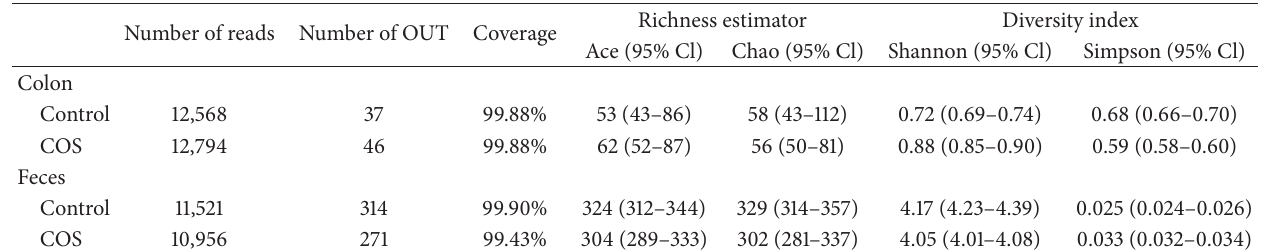
Table 1: Comparative results of 16S rRNA gene libraries’ phylotype coverage and diversity at 97% similarity based on pyrosequencing analysis ( 𝑛 = 6